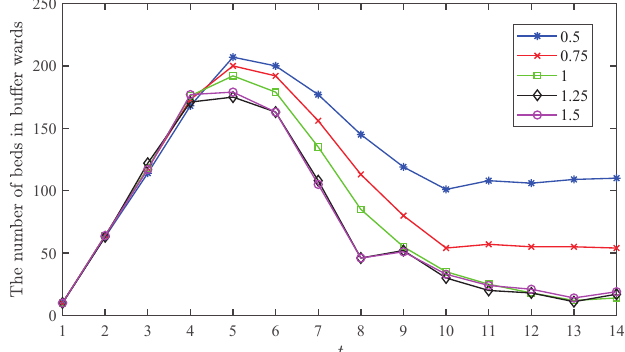
Figure 11. The number of beds in buffer wards in case